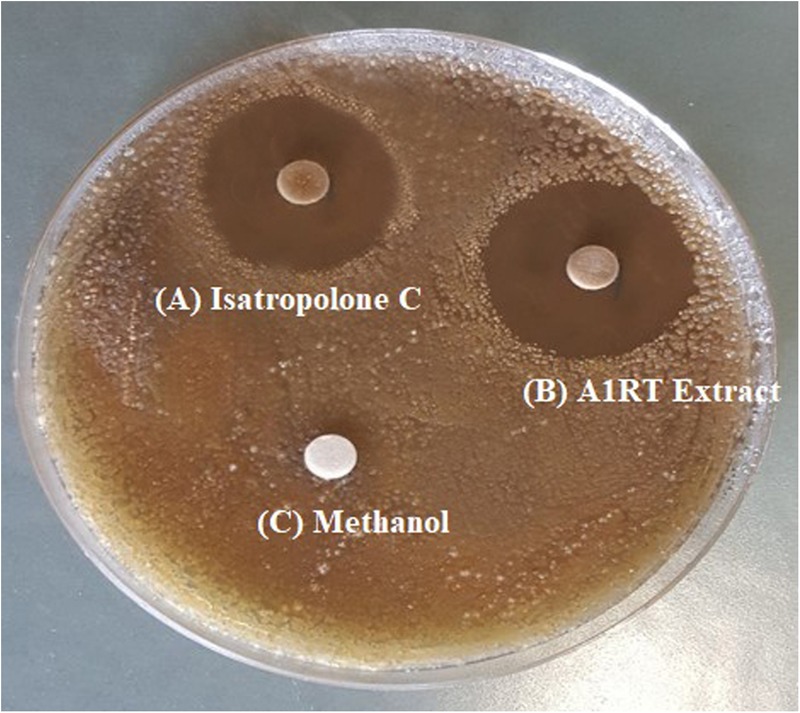
Inhibition of S. scabies by disk diffusion assay. S. scabies strain AC46 was grown on a solid medium plate in the presence of filter paper disks containing (A) Purified Isatropolone C dissolved in methanol. (B) Crude extract of Streptomyces A1RT (C) Methanol only.